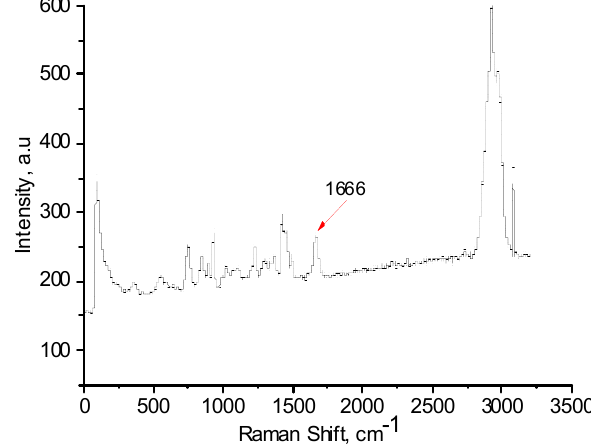
Figure 9. FTIR spectra of κ -carrageenan ( a ) and κ -carrageenan-AuNPs ( b ).